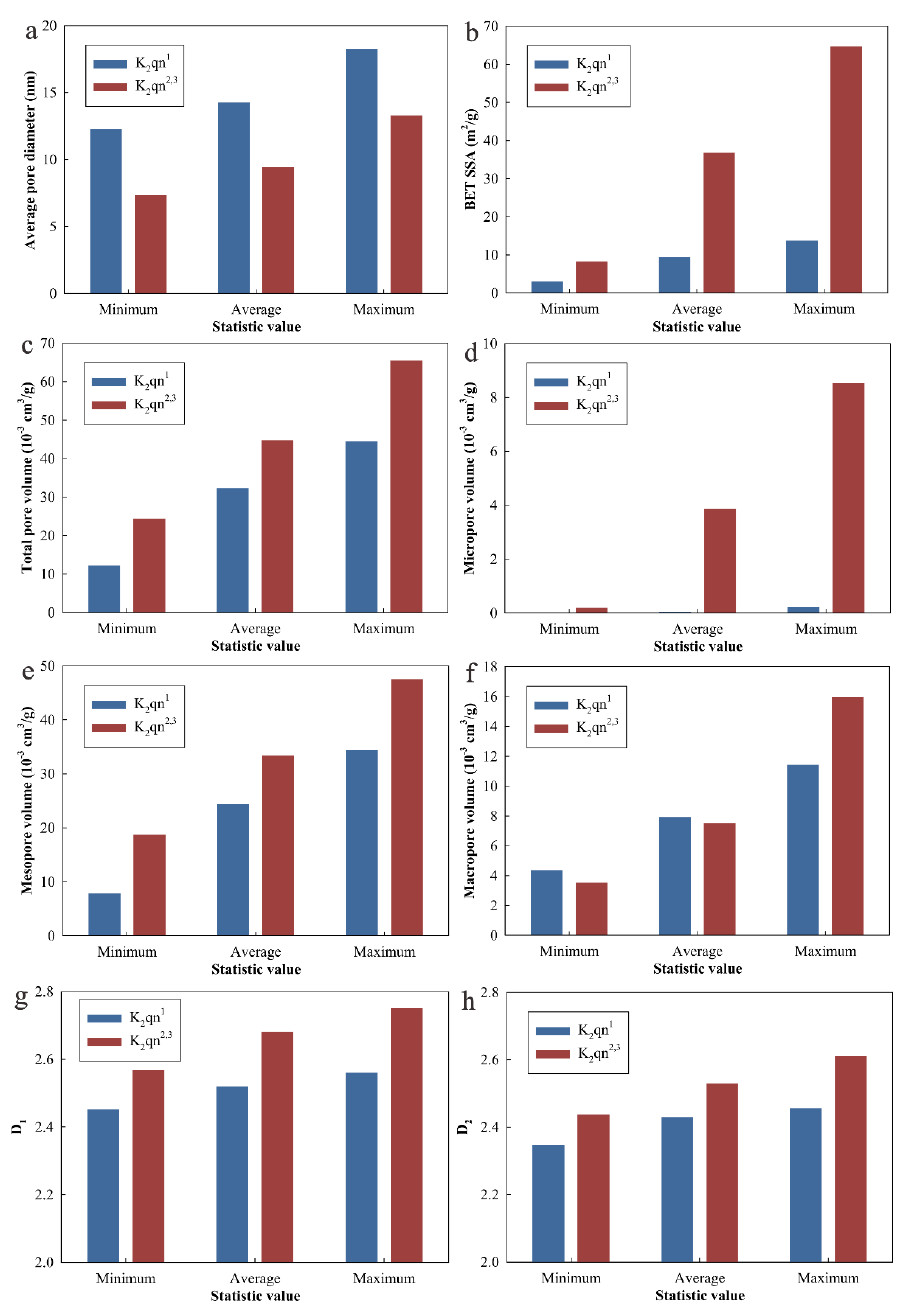
Figure 7. The statistic values of pore structure parameters and fractal dimensions in K 2 qn 1 and K 2 qn 2,3 . ( a ) Average pore diameter; ( b ) BET SSA; ( c ) total pore volume; ( d ) micropore volume; ( e ) mesopore volume; ( f ) macropore volume; ( g ) D 1 ; and ( h ) D 2 .